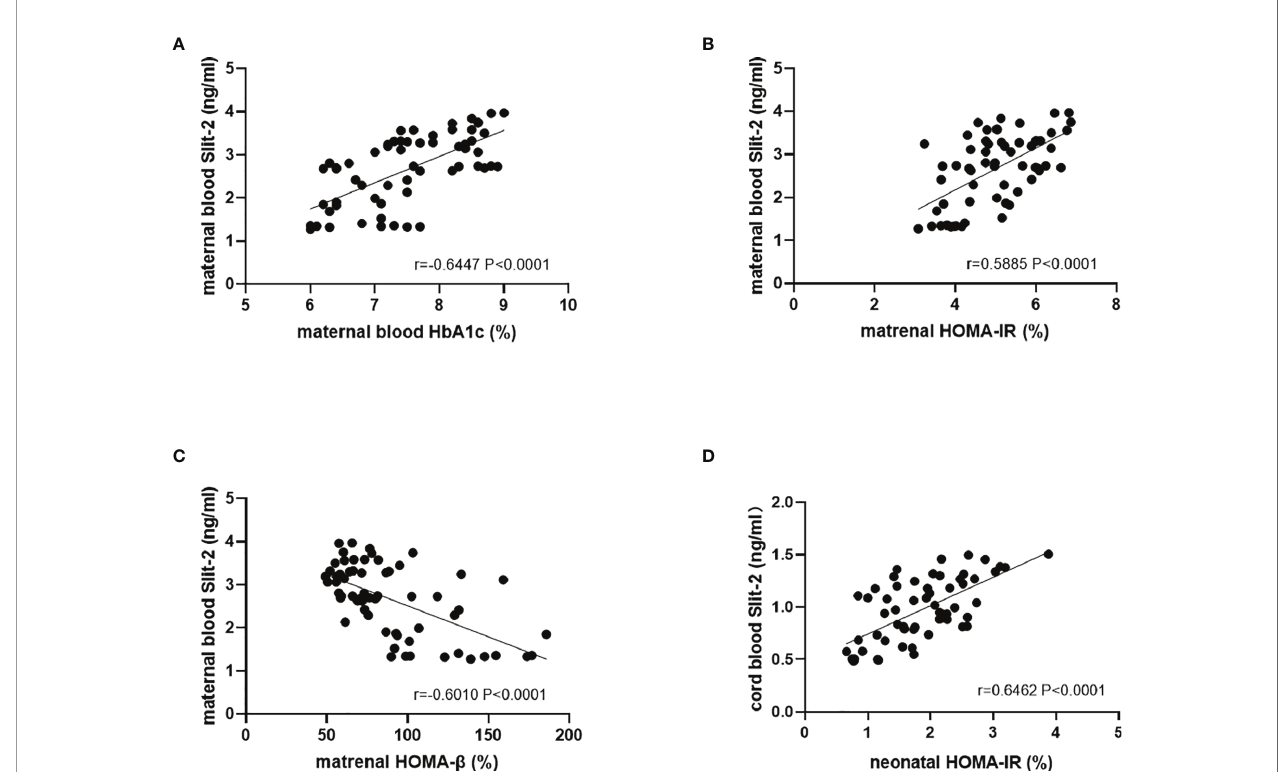
FIGURE 3 | Correlation between the Slit-2, HbA1c and HOMA in maternal peripheral blood and neonatal cord blood of the patients with GDM. (A) Correlation between the Slit-2 level and HbA1c in maternal peripheral blood of the patients with GDM. (B) Correlation between the Slit-2 level and HOMA-IR in maternal peripheral blood of the patients with GDM. (C) Correlation between the Slit-2 level and HOMA- b in maternal peripheral blood of the patients with GDM. (D) Correlation between the Slit-2 level and HOMA-IR in neonatal cord blood of the patients with GDM. Slit-2, Slit guidance ligand 2; HOMA-IR, Homeostasis model assessment insulin resistance; HOMA- b , Homeostasis model assessment - b